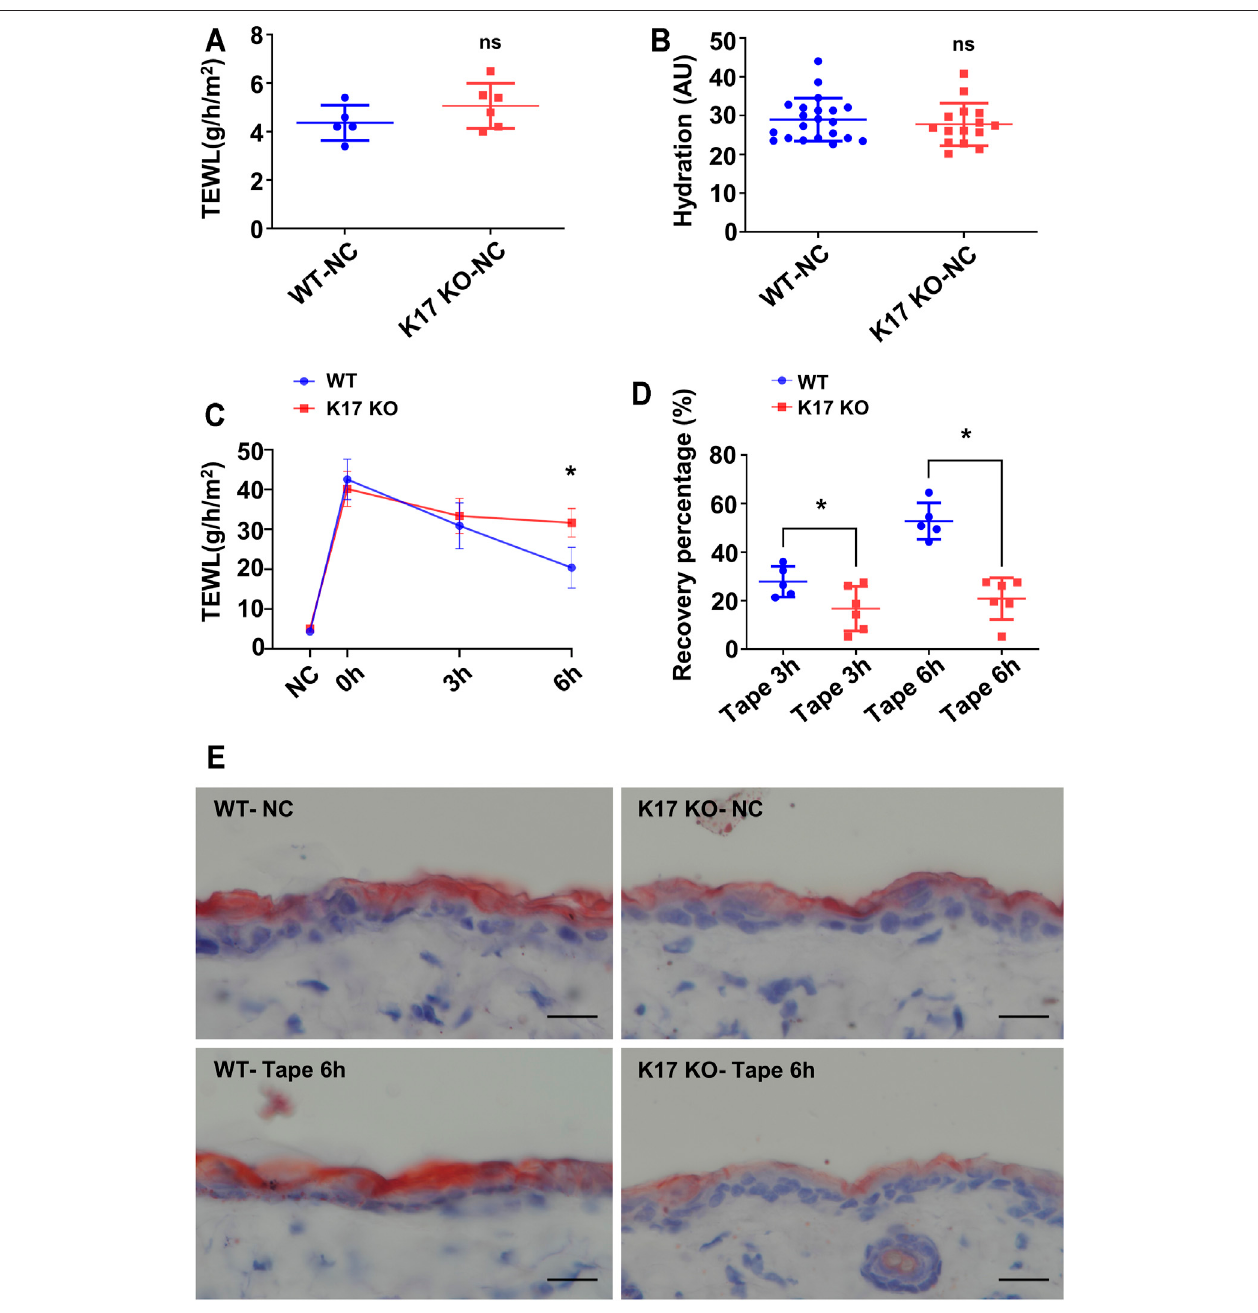
FIGURE2| Theabilityoftheepidermistorepairitselfwasimpairedinkeratin17-nullmice. (A) Trans -epidermalwaterloss(TEWL)inkeratin17( Krt17 )knockoutand wild-type(control)micebeforetapestripping. (B) Thebasallevelsofepidermalhydrationin Krt17 knockoutandwild-type(control)mice. (C) TEWLmonitoringat0,3,and 6 h after permeability barrier disruption. (D) Recovery rate at 3 and 6 h. (E) Oil Red O staining of biopsies at steady state and 6 h after disruption. Scale bars (cid:1) 20 μ m* p < 0.05.